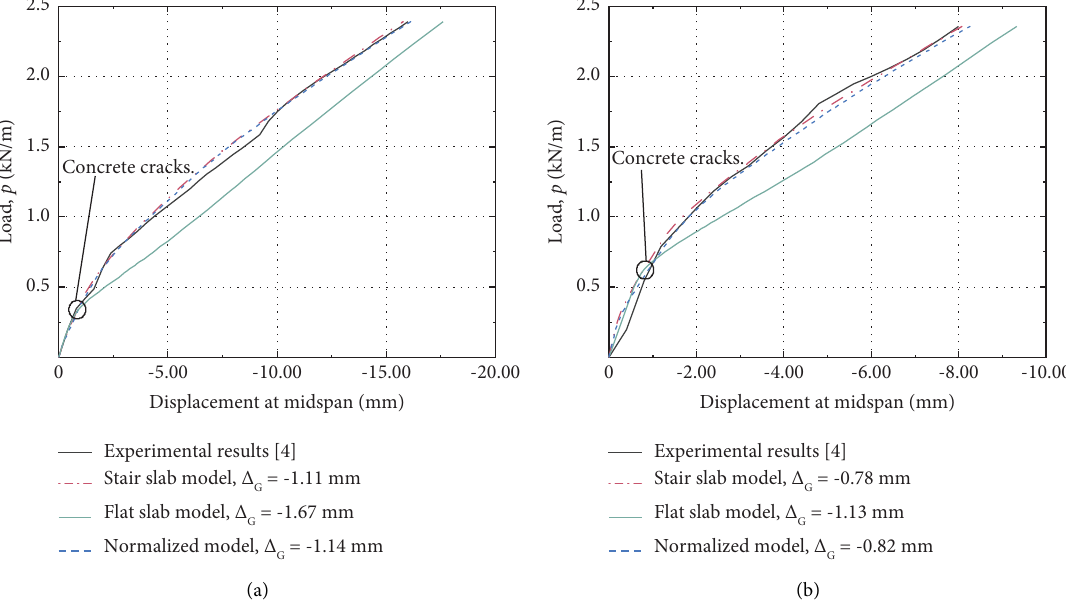
Figure 6: Load-displacement curves in the experimental results [4] and the simulation results for the stair slabs with diferent thicknesses. (a) t � 70mm. (b) t �